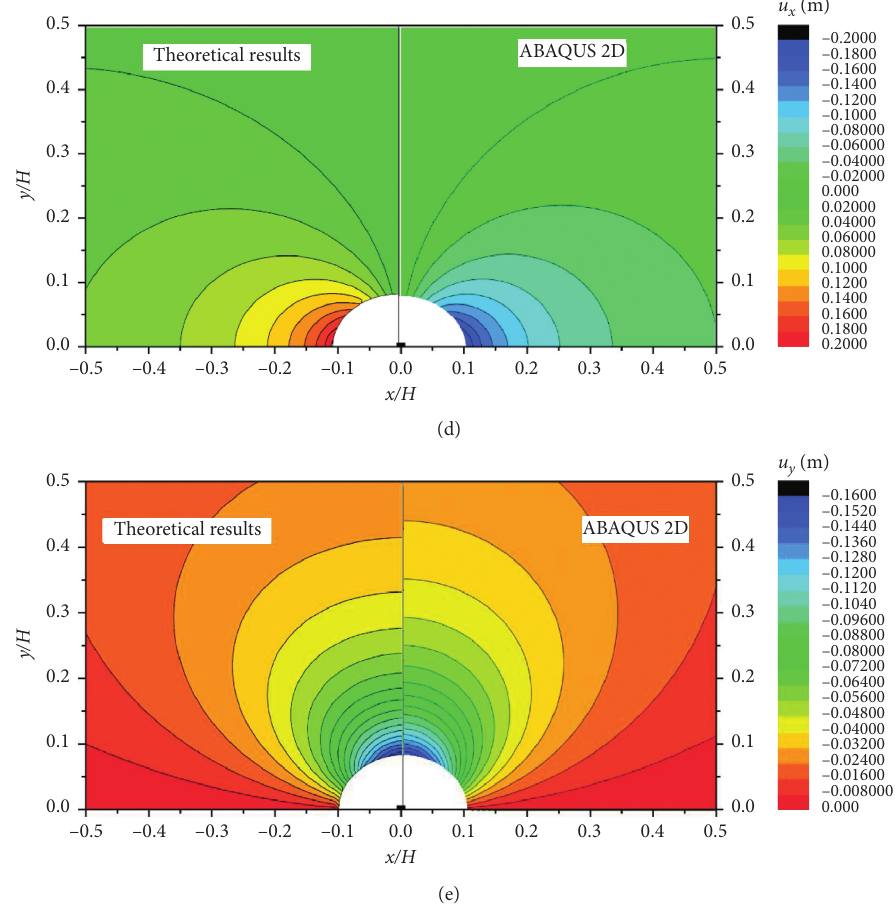
Figure 7: Contours of the normalized stresses and displacements in the case of (a)/(b) � 2 as derived by the theoretical method and ABAQUS 2D. (a) Shear stress of the soil. (b) Soil stress in the x -direction. (c) Soil stress in the y -direction. (d) Soil displacement in the x - direction. (e) Soil displacement in the y